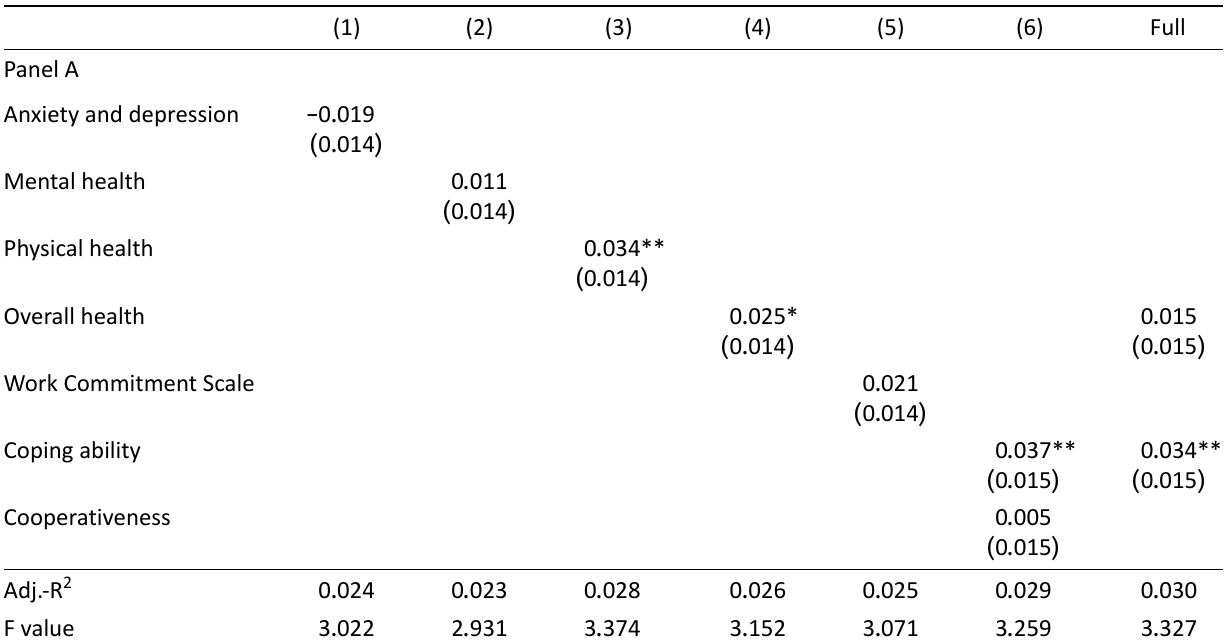
Table 3. Finding a decent first